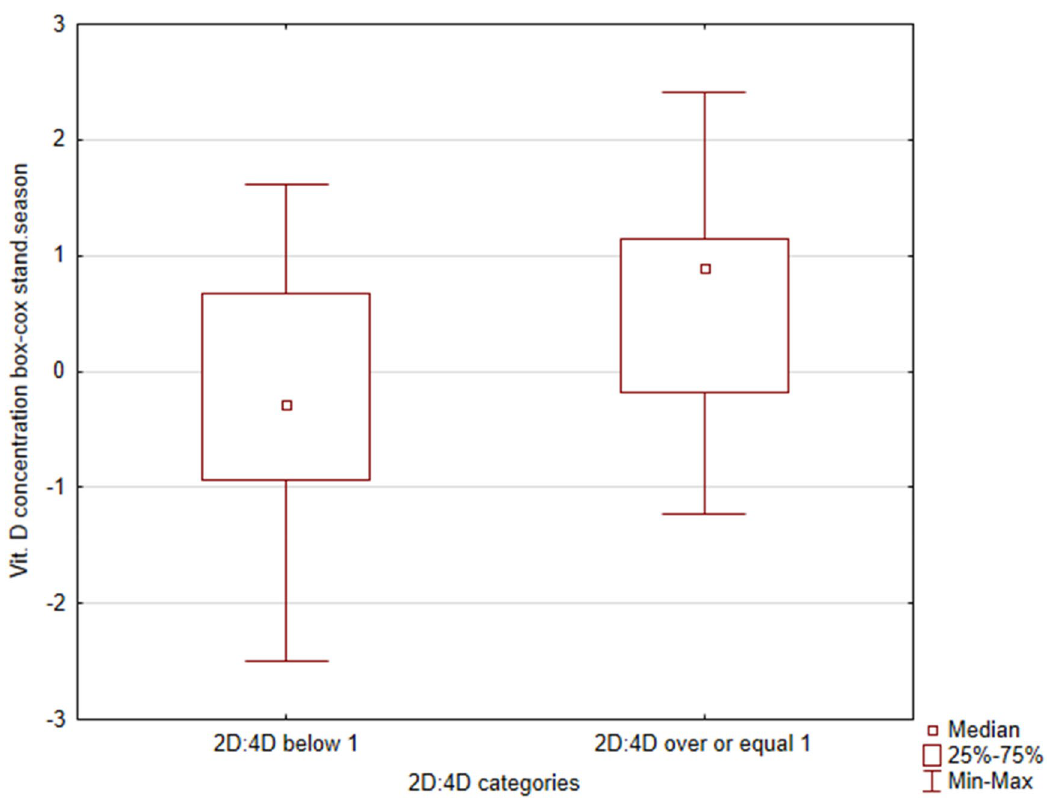
Figure 1. Difference in vitamin D concentration between boys with 2D:4D < 1 or ≥ 1.